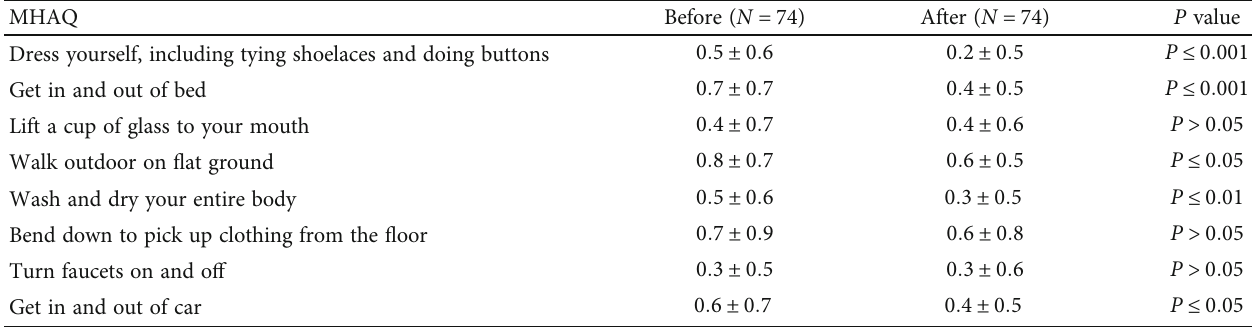
Figure 1: Flow chart of the registrations. Total registrations in the department of telemedicine during lockdown and fi nal registrations in the rheumatology clinic after the exclusion of duplication and lost to follow-up. Table 1: Modi fi ed health assessment questionnaire